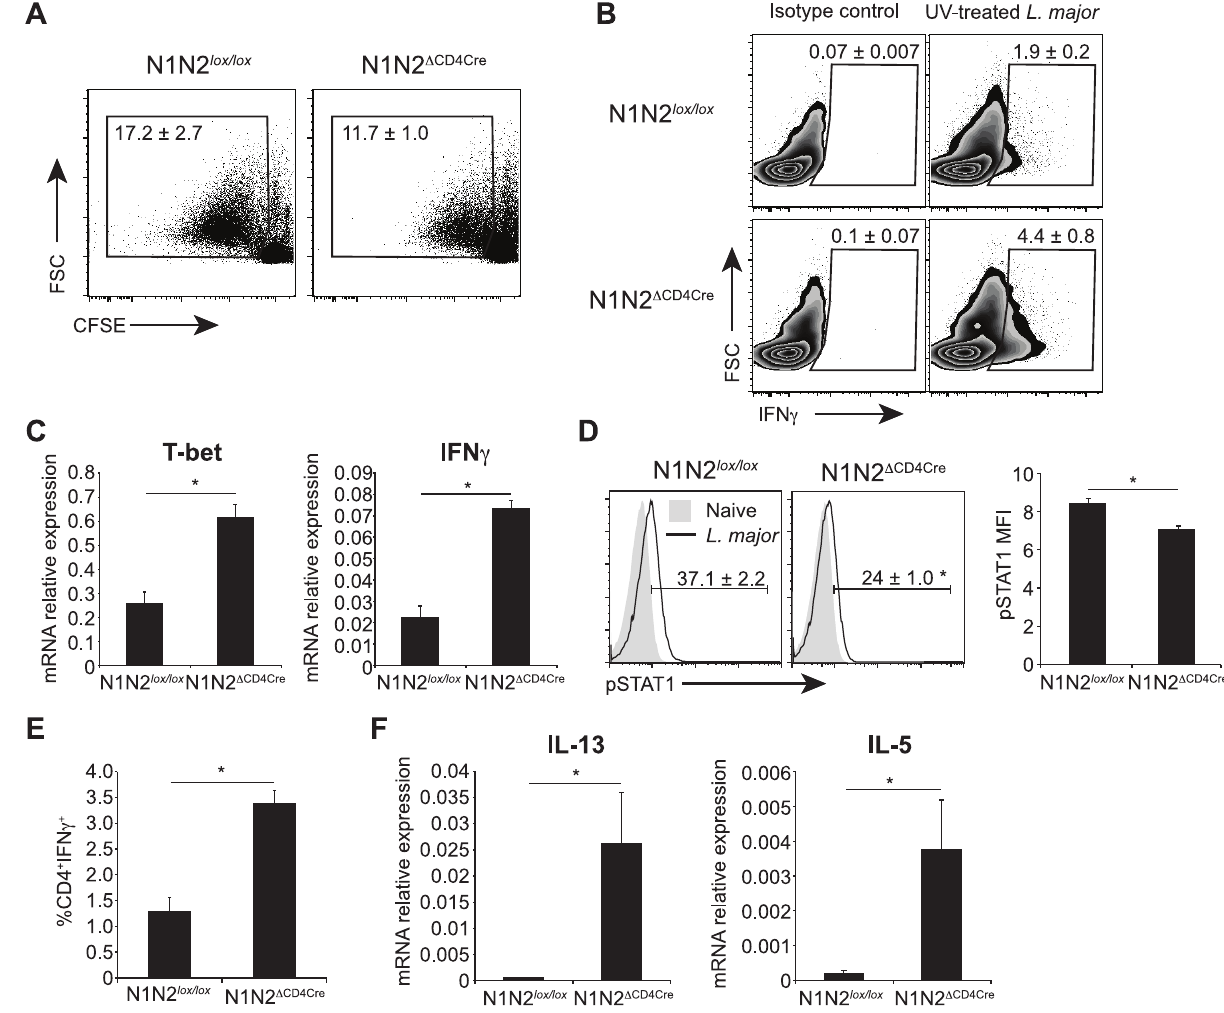
Figure 5. N1N2 D CD4Cre mice transcribe T-bet and IFN c in dLN CD4 + T cells but do not secrete it. (A) Proliferation of CD4 + T cells was assessed by FACS. Draining LN cells of L. major -infected mice were isolated 6 weeks after infection, stained with CFSE and restimulated with UV- treated L. major for 72 h. Representative flow cytometry plots gated on CD4 + T cells are shown. Numbers in plots represent the mean percentage of proliferating cells 6 SEM for 5 mice. (B) Intracellular levels of IFN c were analysed by FACS in L. major -infected dLN cells restimulated for 72 h with UV- treated L. major . Representative flow cytometry plots are given. Numbers in plots represent the mean percentage of IFN c + cells within CD4 + T cells 6 SEM for 5 mice. (C) Draining LN CD4 + T cells from N1N2 D CD4Cre and N1N2 lox/lox mice were sorted by FACS 21 days post L. major infection, T-bet and IFN c mRNA levels were analyzed by quantitative RT-PCR. Data are represented as the mean 6 SEM mRNA transcript levels normalized to HPRT mRNA levels (n $ 3 mice per group). (D) Phosphorylation of STAT1 was assessed by FACS on dLN cells of N1N2 D CD4Cre and N1N2 lox/lox mice 3 weeks post infection. Naive mice were used as control. Representative flow cytometry plots gated on CD4 + T cells are shown. Numbers in quadrants indicate the mean frequency of pSTAT1 + CD4 + T cells 6 SEM. pSTAT1 mean fluorescence intensity MFI 6 SEM is shown (n $ 3 mice per group). (E) Draining LN cells of L. major -infected mice were restimulated ex vivo with PMA/ionomcyin for 4 h and level of intracellular IFN c was assessed by FACS. The frequency of CD4 + IFN c + T cells is given 6 SEM for n $ 3 mice per group. (F) mRNA expression of IL-13 and IL-5 was analyzed by quantitative real-time PCR in dLN cells isolated from N1N2 D CD4Cre and N1N2 lox/lox mice 6 weeks post L. major infection. Results are given as mean mRNA expression relative to HPRT 6 SEM for n $ 3 mice per group. Data are representative of 2–3 individual experiments. * p-value , 0.05 versus control